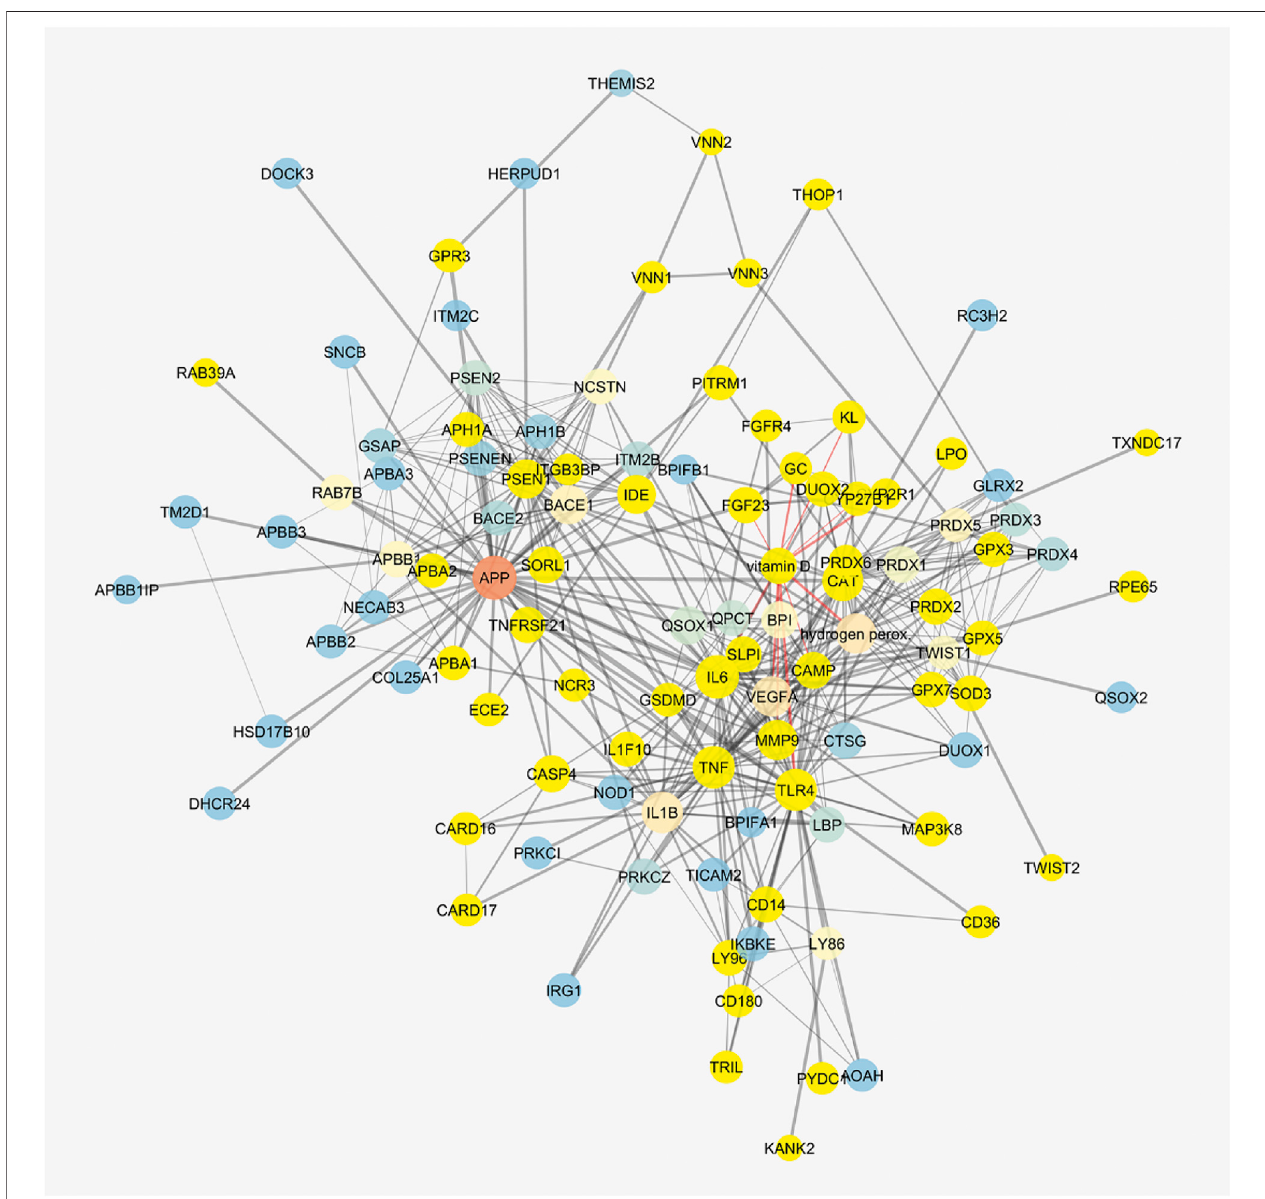
FIGURE 8 | Vitamin D 3 – interacting nodes cover most of the STITCH protein – compound network. Red edges highlight direct interactions with vitamin D 3 , and yellow nodes represent direct and indirect interactors of vitamin D 3 .